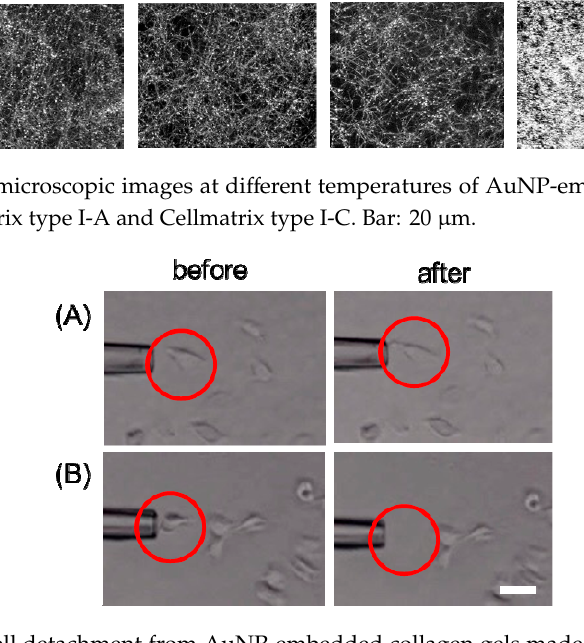
Figure 10. Single cell detachment from AuNP-embedded collagen gels made from Cellmatrix type I-A ( A , AuCol-IA) and Cellmatrix type I-C ( B , AuCol-IC) by photoirradiation for 2 s and subsequent aspiration. The photoirradiated cells are marked with a circle. Bar. 30 µm.